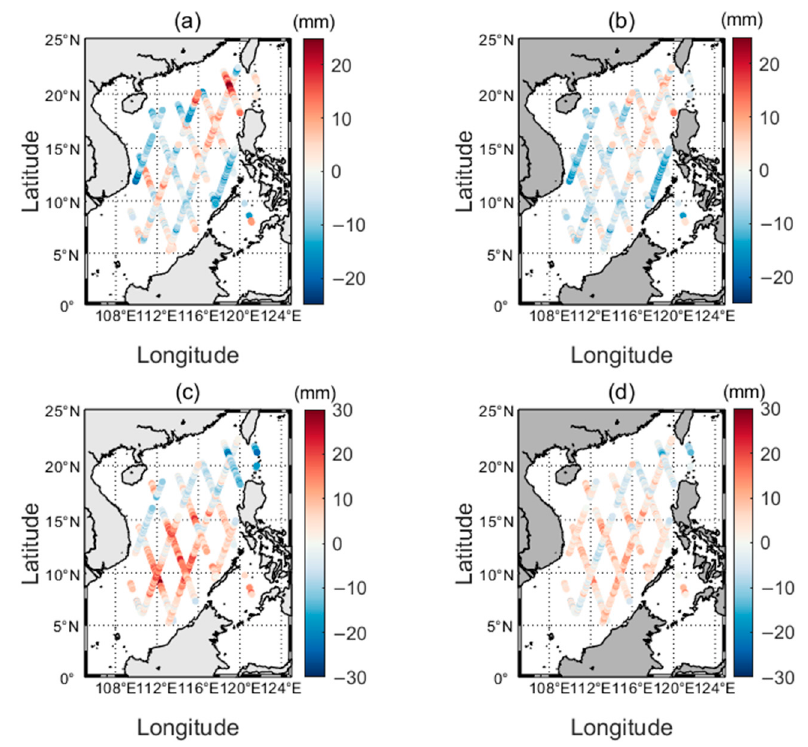
Figure 9. Comparison of the evolution of M 2 and S 2 tidal amplitudes before and after the MVC: ( a ) evolution of M 2 tidal amplitudes before correction; ( b ) evolution of M 2 tidal amplitudes after correction; ( c ) evolution of S 2 tidal amplitudes before correction; ( d ) evolution of S 2 tidal amplitudes after correction.